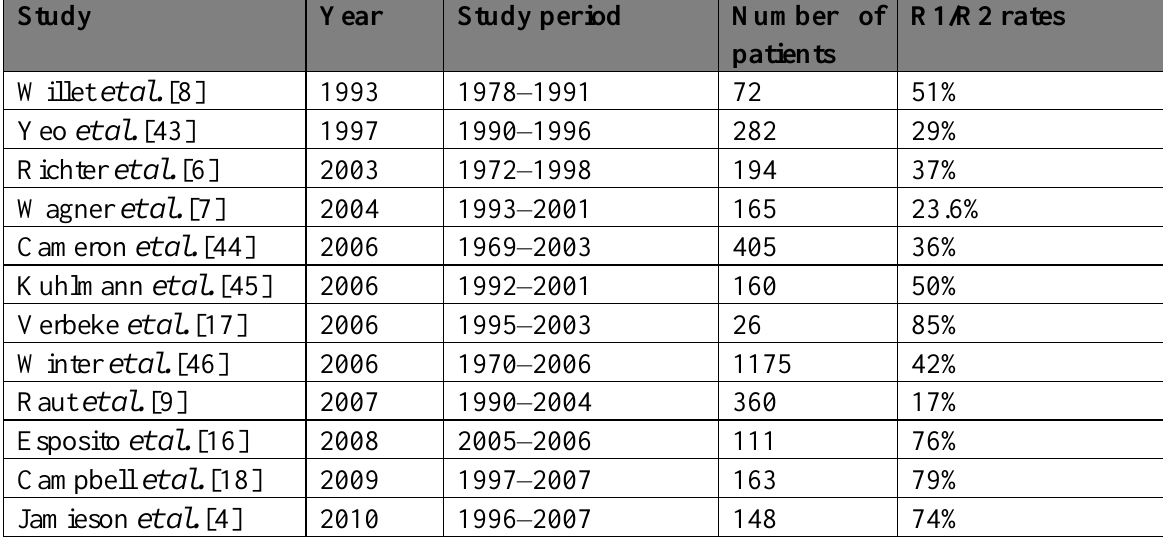
Table 1. Comparison of R1 rates for